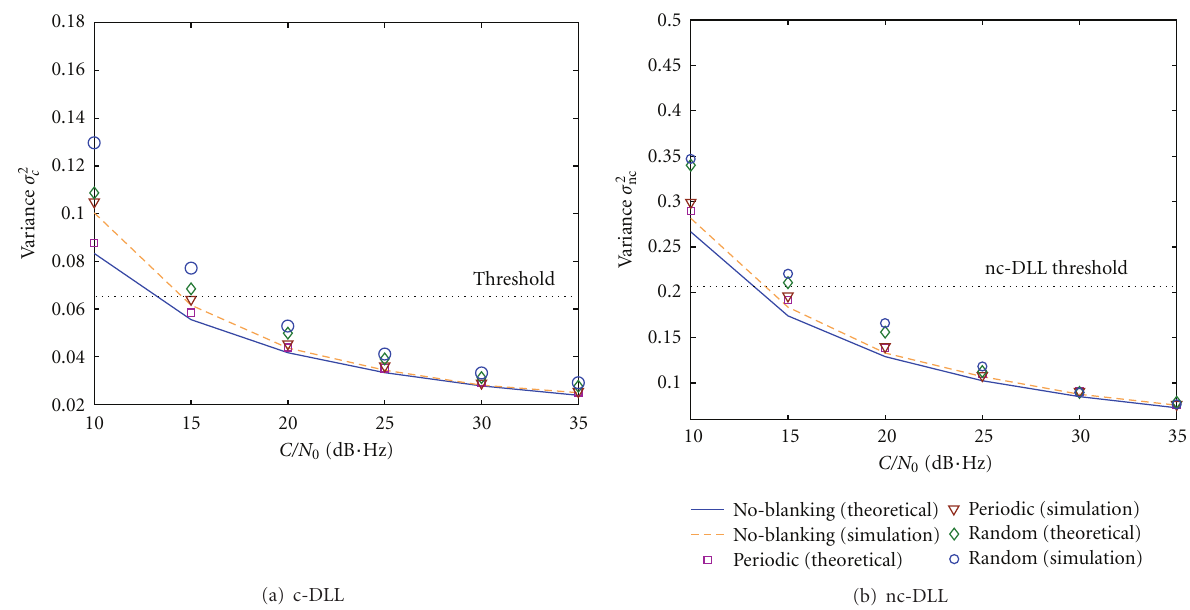
Figure 6: Code delay error variance versus C/N 0 ( T p = 5%, and Pr( u ) = 0 .